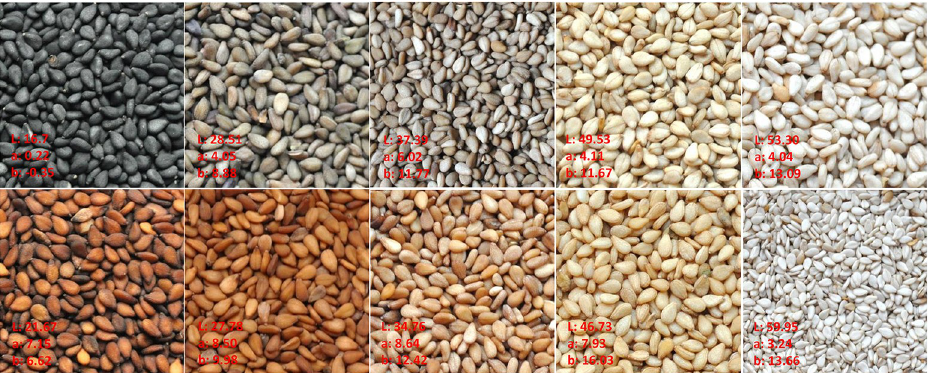
Fig 2. Seed coat color variation in sesame association